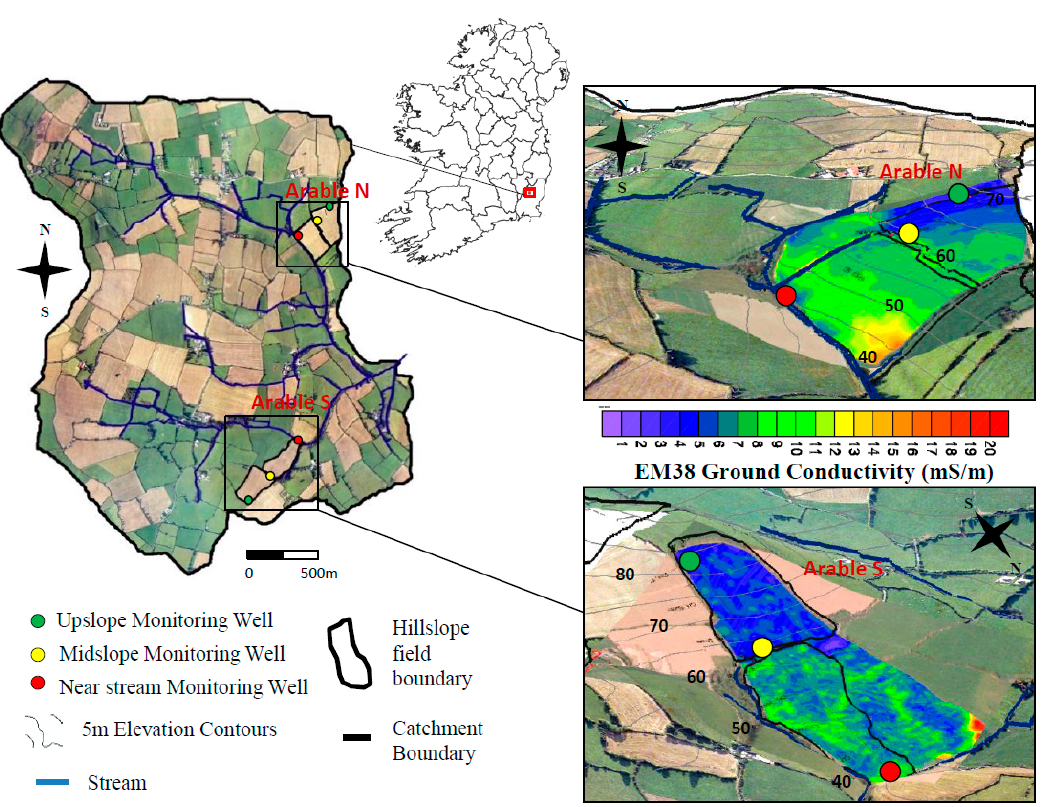
Figure 2. Arable catchment area, hillslope field boundaries, monitoring wells and orthoim- agery/electromagnetic ground conductivity (EM38) survey digitally grafted onto a catchment digital elevation model. The black field boundaries represent the areas where field specific agronomic information was available. Table 2. Groundwater monitoring points used in the study: location, depth and lithology.